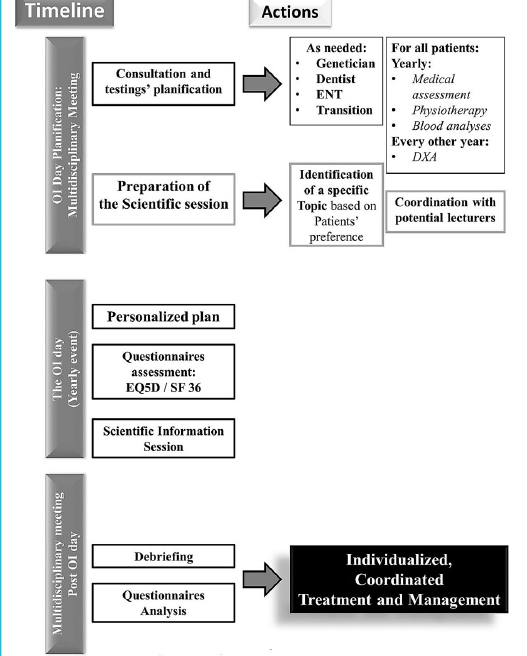
Figure 2: The OI day – planning of individualised follow-up. OI: Osteogenesis Imperfecta. CHUV Centre Hospitalier Universitaire Vaudois. DXA = dual X-ray